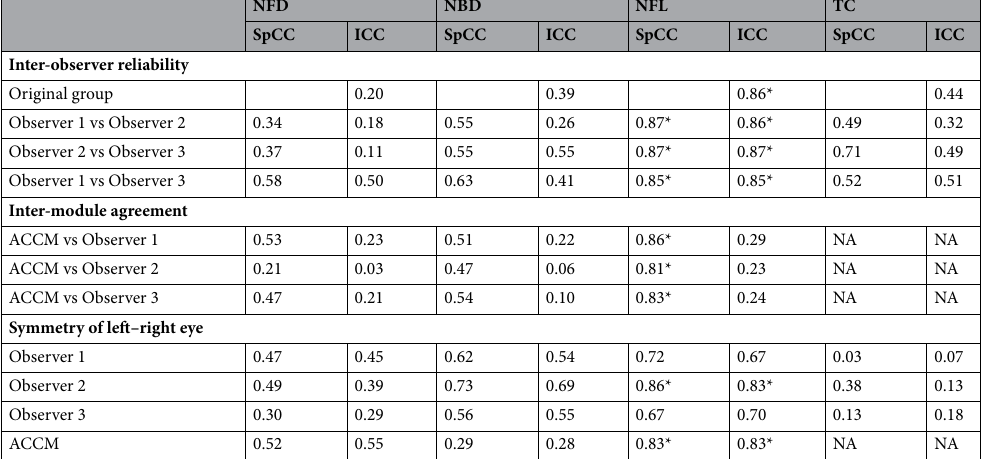
Table 3. The Spearman correlation coefficient (SpCC) and intraclass correlation coefficient (ICC) to assess inter-observer reliability and inter-module agreement between CCMetrics and ACCMetrics and the left– right eye symmetry for the original group. NFD (nerve fiber density) is measured in number of fibers/mm 2 , NBD (nerve branch density) is measured in number of branch points on the main fibers/mm 2 , NFL (nerve fiber length) is measured in total length of fiber (mm/mm 2 ), TC (tortuosity coefficient) is measured in main fiber average tortuosity, SpCC Spearman correlation coefficient, ICC intraclass correlation coefficient, ACCM ACCMetrics module. The CCM data from the first evaluation in all 3 observers were compared with ACCM data, NA not applicable. *Represents an excellent correlation when values > 0.8.